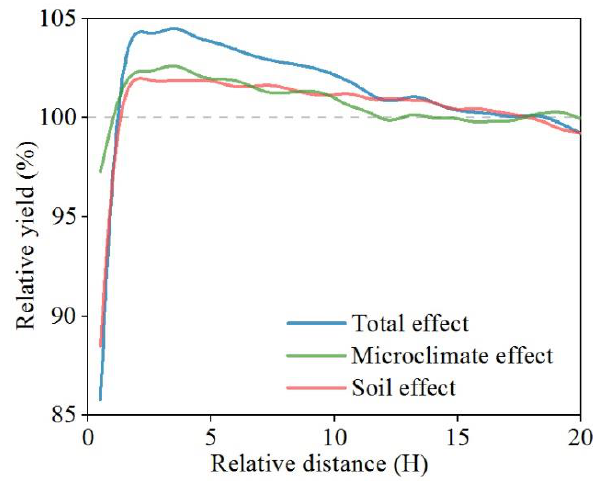
Figure 6. Decomposition of the total effect (blue line) into microclimate effect (green line) and soil effect (red line). The total effect and soil effect are represented by the yield profiles before and after shelterbelt cutting, respectively. The microclimate effect is represented by the difference between the yield profiles before and after shelterbelt cutting.